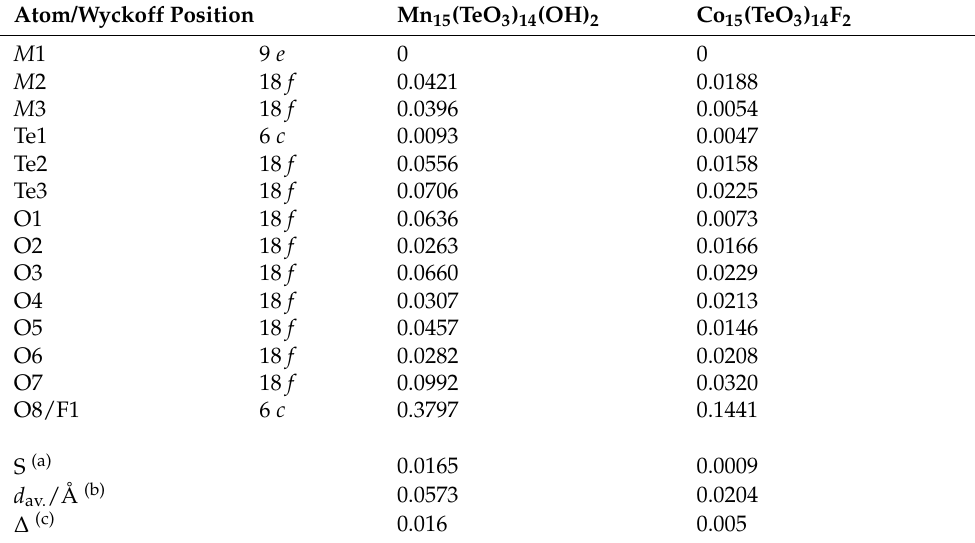
Table 3. Comparison of Co 15 (TeO 3 ) 14 (OH) 2 as the reference structure with isotypic Mn 15 (TeO 3 ) 14 (OH) 2 and Co 15 (TeO 3 ) 14 F 2 . Atom pairs are given with their absolute distances |u|/Å, as well as the degree of lattice distortion (S), the arithmetic mean of the distances ( d av /Å) and the measure of similarity ( ∆ ). Atom/Wyckoff Position Mn 15 (TeO 3 ) 14 (OH) 2 Co 15 (TeO 3 ) 14 F 2 M 1 9 e 0 0 0.0421